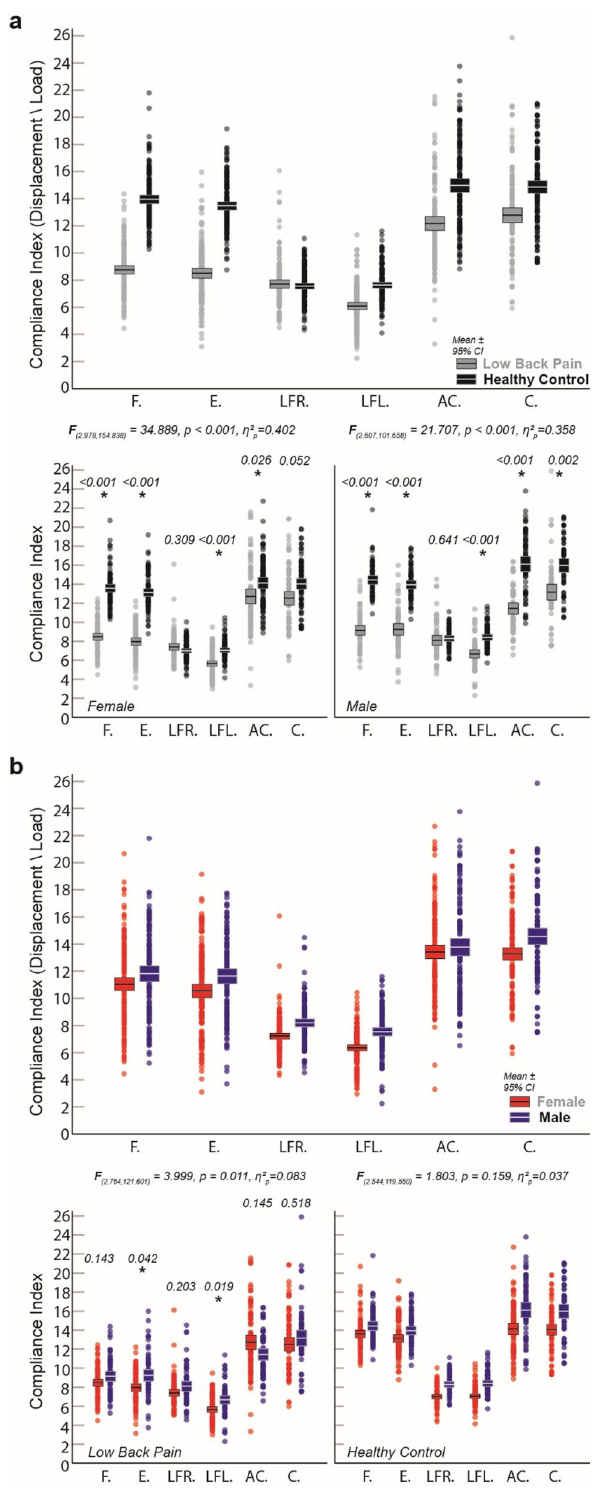
Figure 2. Mean differences in Trunk Compliance Index across 6 directions of trunk position perturbation. ( a ) Comparisons were split by chronic low back pain (a, grey) and matched healthy controls (a, black). ( b ) Color comparisons were split by biological sex (females, red; males, blue). * P < 0.05 Bonferroni-adjusted; All individual values reported with bars representing mean + 95% confidence interval. Abbreviations: F, Flexion; E, Extension; LFR, Lateral Flexion (Right); LFL, Lateral Flexion (Left); AC, Anti-clockwise (rightward) rotation; C, Clockwise (leftward)